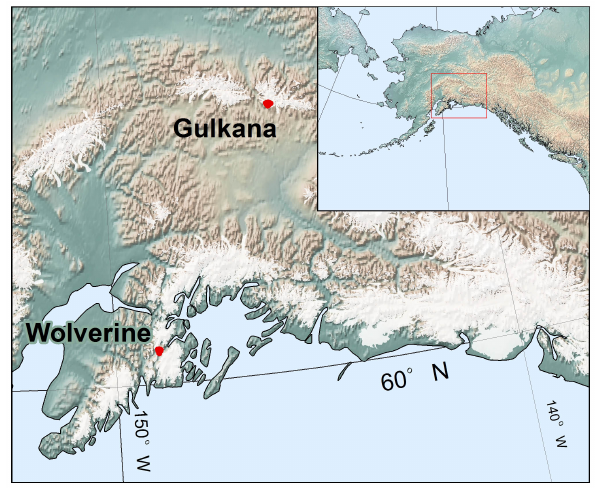
Figure 1. Map of southern Alaska with study glaciers marked by red outline. All glaciers in the region are shown in white (Pfeffer et al., 2014).